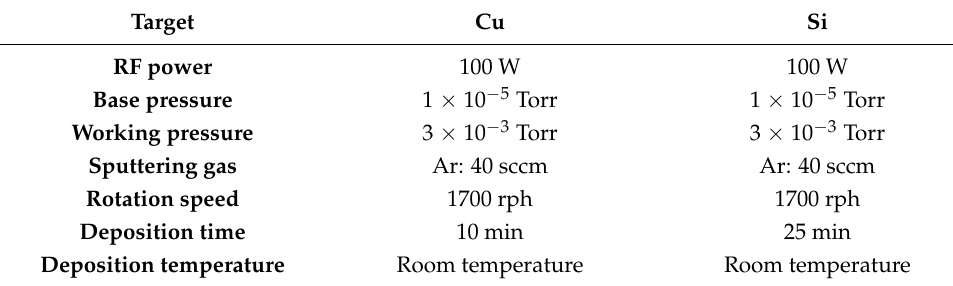
Table 2. Conditions of deposition of Cu and Si layers via RF